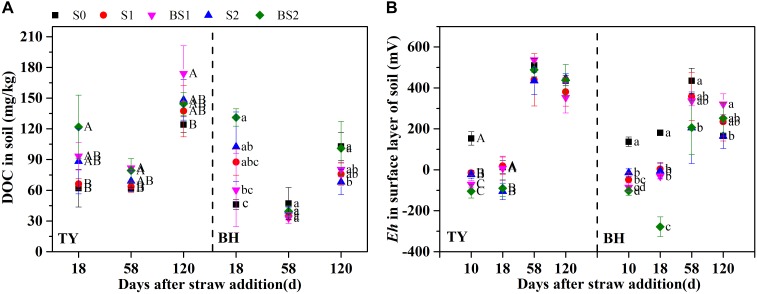
Soil dissolved organic carbon contents (A) and redox potential in surface layer of paddy soil (B) among the treatments during rice growing season in 2016. Error bars present standard deviation of means (n = 3). The different letters (capital letter for the TY soil and lowercase for the BH soil) indicate significant difference among treatments at each stage, which is analyzed by Duncan’s multiple range test (P < 0.05).